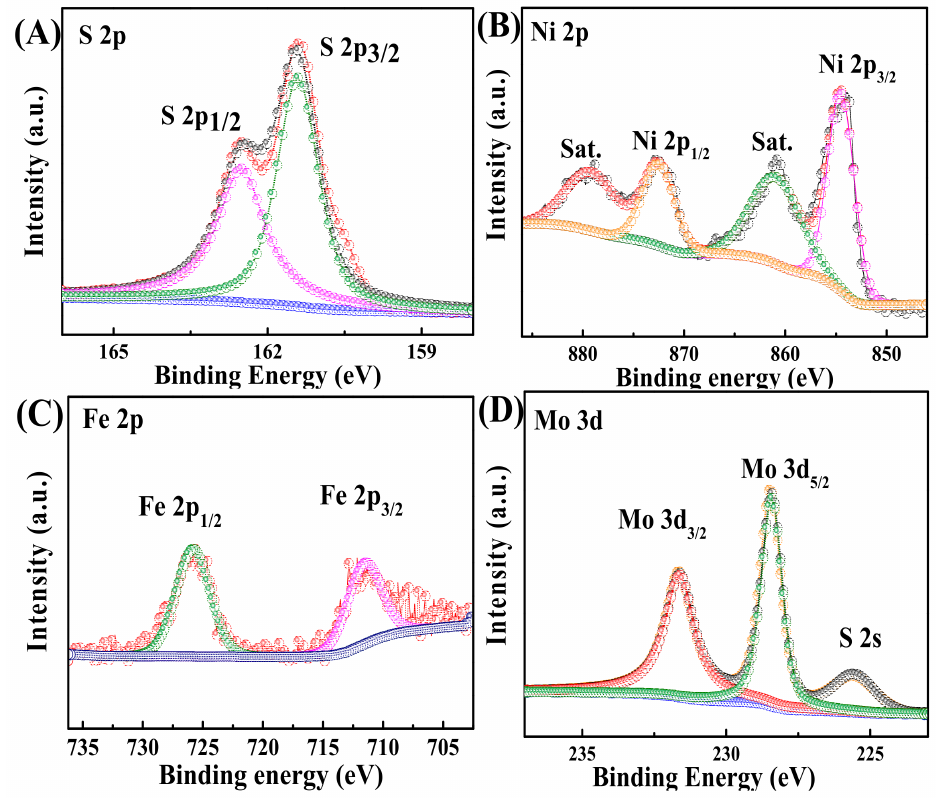
Figure 2. XPS spectra of MoS 2 /LDH-5% composites: ( A ) S 2p, ( B ) Ni 2p, ( C ) Fe 2p and ( D ) Mo